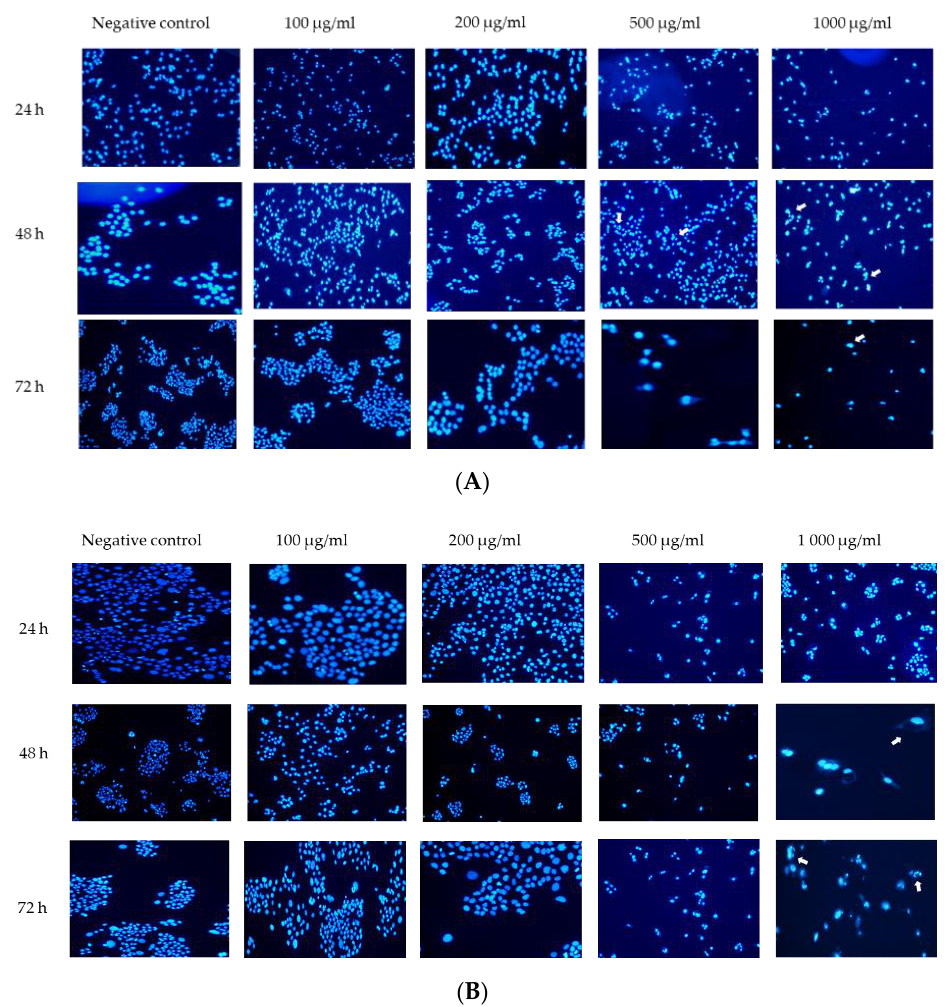
Figure 4. Nuclear changes of the human melanoma (A375) cells ( A ) and normal human skin (HaCaT) cells ( B ) by the G. africana ethanolic extract. After treatment with 100; 200; 500 and 1000 µg/mL the cell lines were stained with Hoechst for 24, 48 and 72 h. The photographs under a fluorescence microscope were shown (20 × ). Arrows show apoptotic features such as nuclear shrinkage, chromatin condensation, irregularly shaped nuclear and nuclear fragmentation.